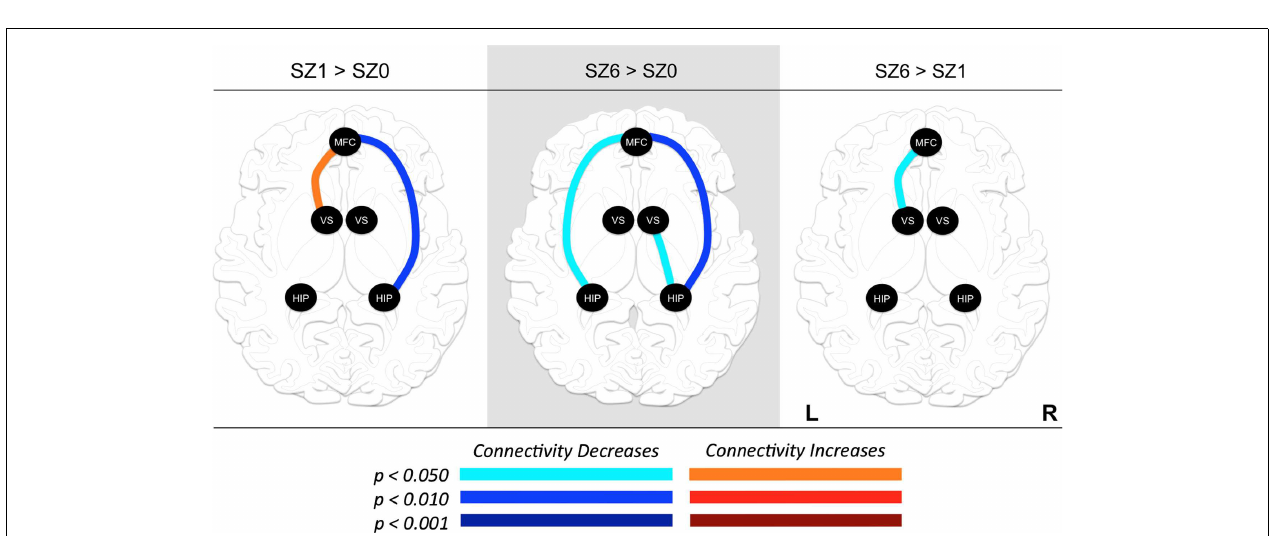
FIGURE 4 | Changes in functional connectivity between regions of interest (ROI) during combined tasks from baseline to week one of antipsychotic drug treatment (left), baseline to week six of antipsychotic drug treatment (center), and between weeks one and six of antipsychotic drug treatment (right). Graph nodes represent ROI; graph